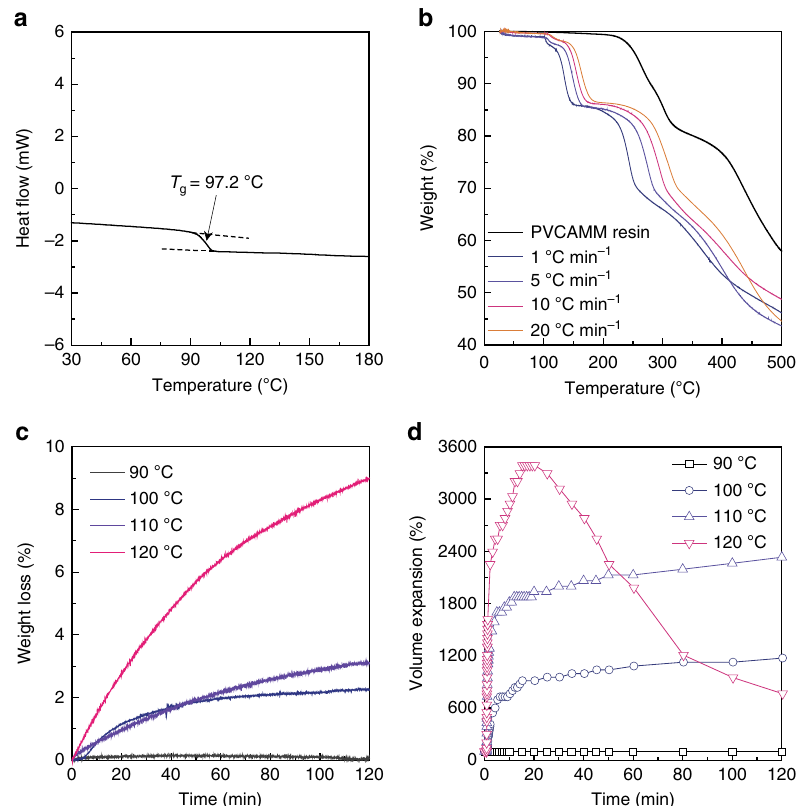
Fig. 2 Thermal expansion behaviors of the microbombs. a Differential scanning calorimetry (DSC) curve of the microbombs, showing the glass transition temperature ( T g ) ~ 97.2 °C. b Thermogravimetric analysis (TGA) curves of the microbombs obtained at different heating rates. c , d Representative isothermal responses of microbombs at different temperatures: c weight loss behavior and d volumetric